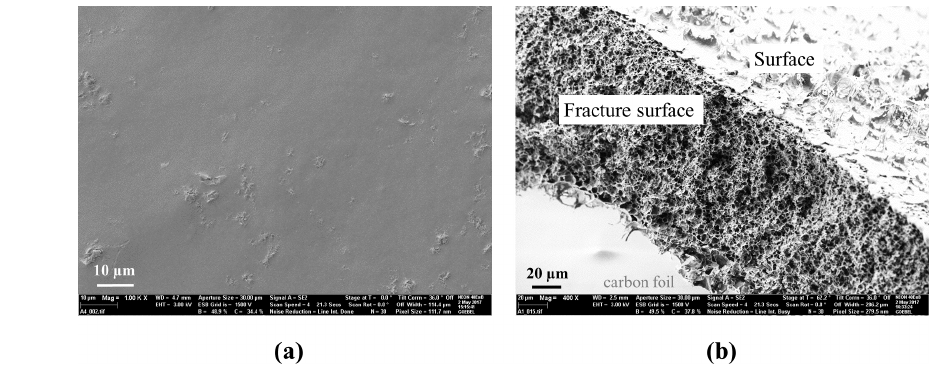
Figure 1. SEM images of (a) the nonporous PNIPAAm and (b) the porous PNIPAAm 1 sample.